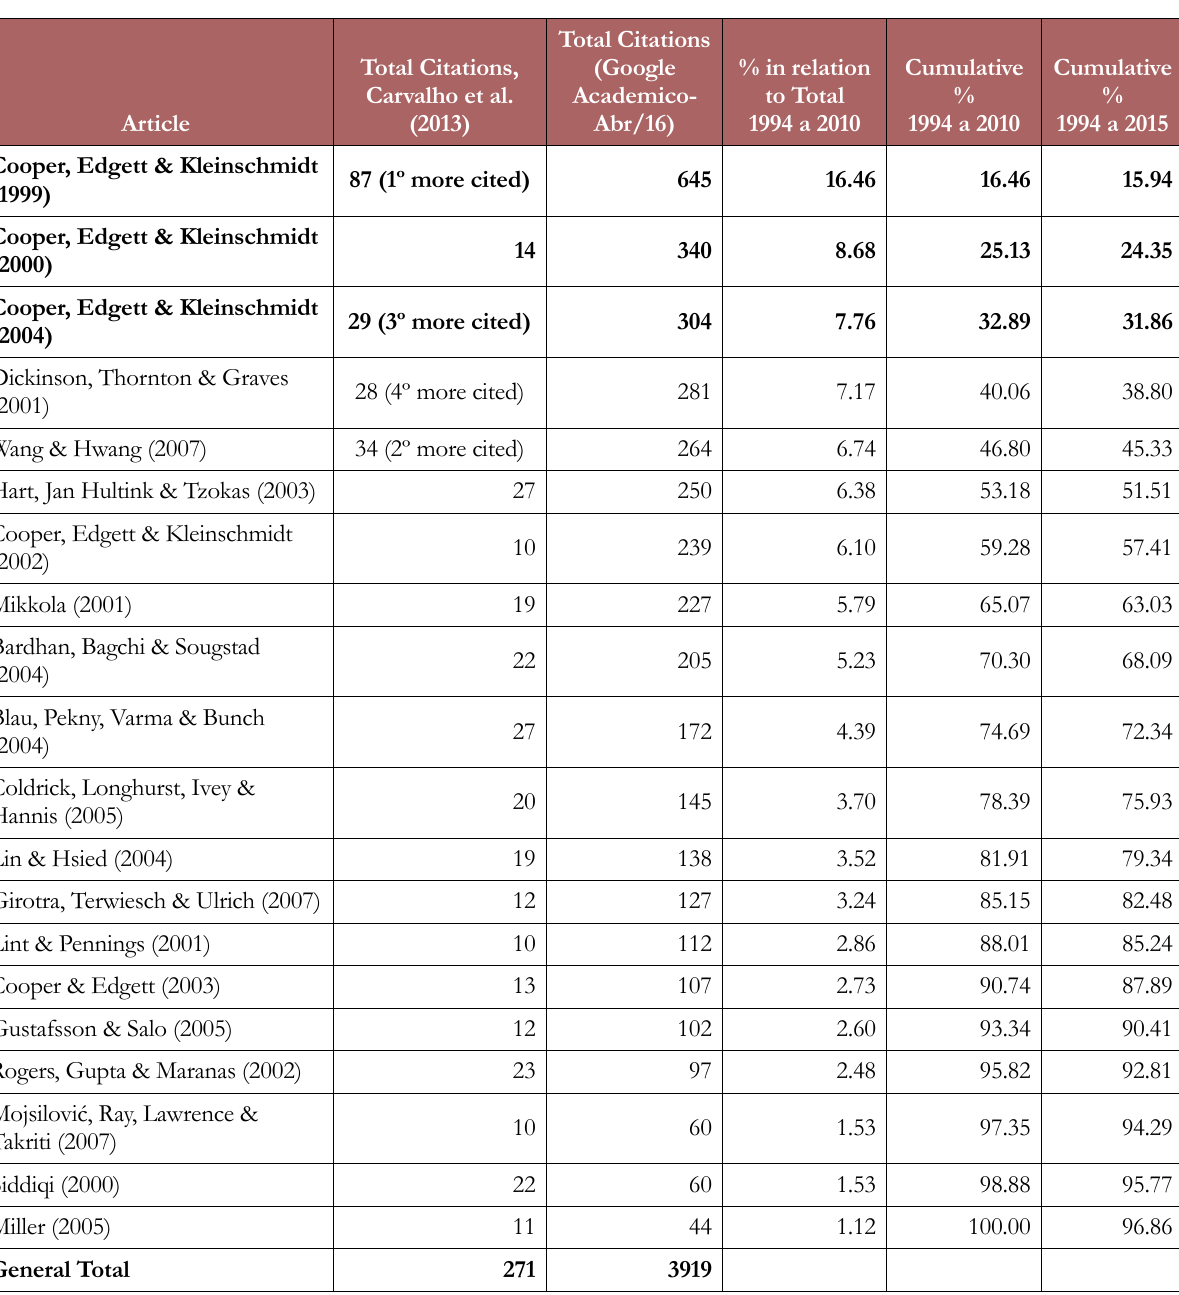
Table 1. Most cited works between 1994 and 2010 (in the survey by Baptestone and Rabechini Jr. (2016), after searching for the key words in the ISI Web of Knowledge database between 2011 and 2015, 81 references were found, and it has been decided that only academic articles would be analysed, due to the peer evaluation process and because they contained the necessary information for bibliometric analysis. Thus, a total of 39 articles were retrieved for further analysis, as shown in Figure